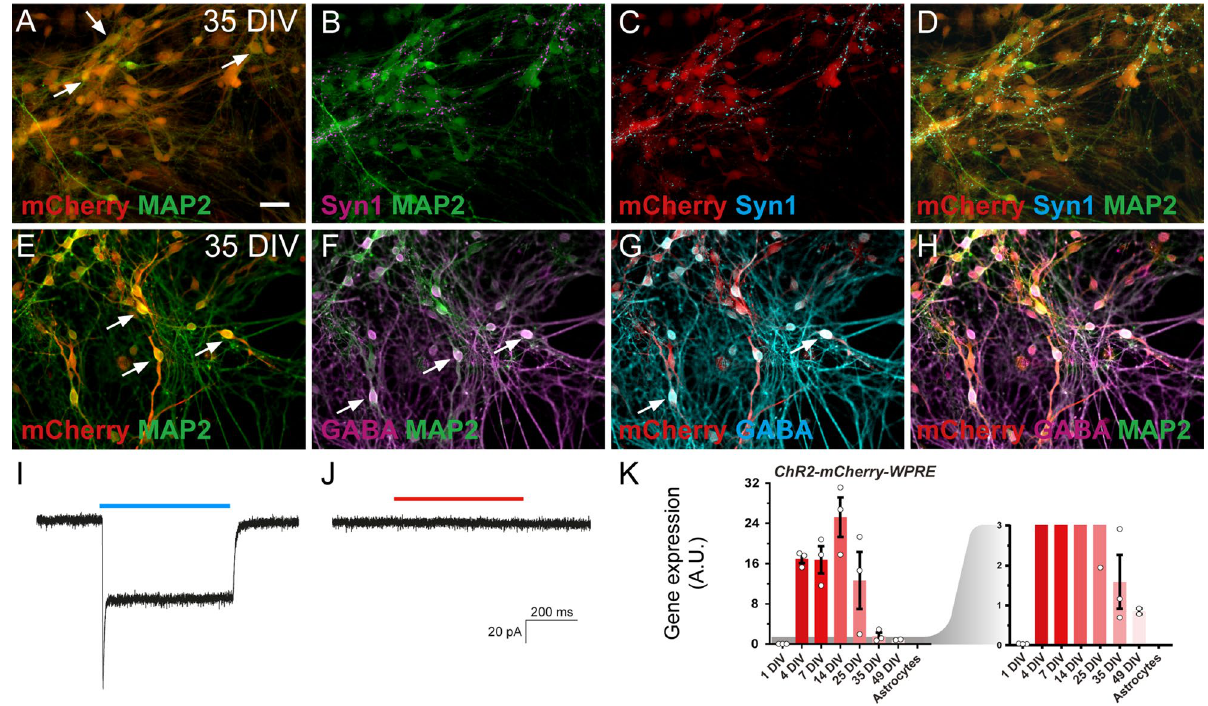
Figure 4. ChR2 is expressed in hdINs, enabling them to respond to blue light. ( A – D ) Immunocytochemistry of hdINs at 35 DIV for the neuronal marker MAP2 + in combination with the fluorescent reporter for ChR2, mCherry +, and a mature neuronal marker Syn1 + in simple differentiation cultures. ( E – H ) Immunocytochemistry indicating the co-expression of GABA + and mCherry + in some hdINs at 35 DIV. White arrows are examples of double positive cells for the indicated markers. ChR2-mCherry + neurons responded to blue light pulse stimulation ( I ), but not to a red-light pulse stimulation ( J ). ( K ) ChR2-mCherry-WPRE expression at different time points of the differentiation, shown in red. A magnified graph for ChR2-mCherry- WPRE values is shown in red as well on the right of the previous graph. Scale bar: 100 µm. Blue light, 460 nm. Red light, 595 nm. Blue and red line, light stimulation for the specific